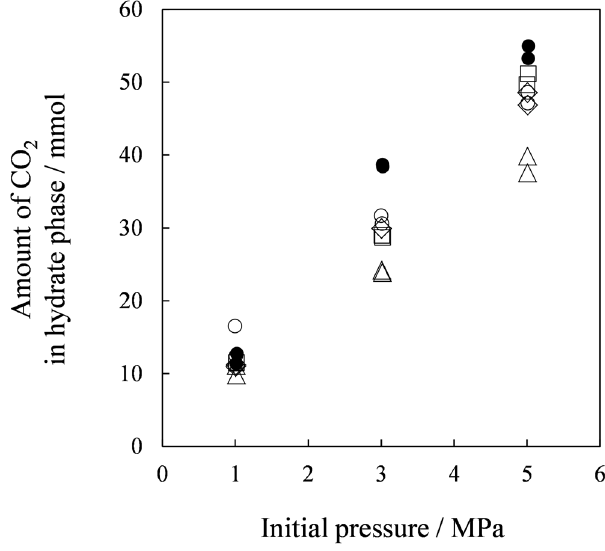
Figure 4. CO 2 amount captured by ionic clathrate hydrates. The symbols show ionic guest substances: ● , TBAB with w = 0.320; ○ , TBAB with w = 0.200; △ , TBAC with w = 0.200; □ , TBPB with w = 0.200; ◊ , TBPC with w = 0.200.